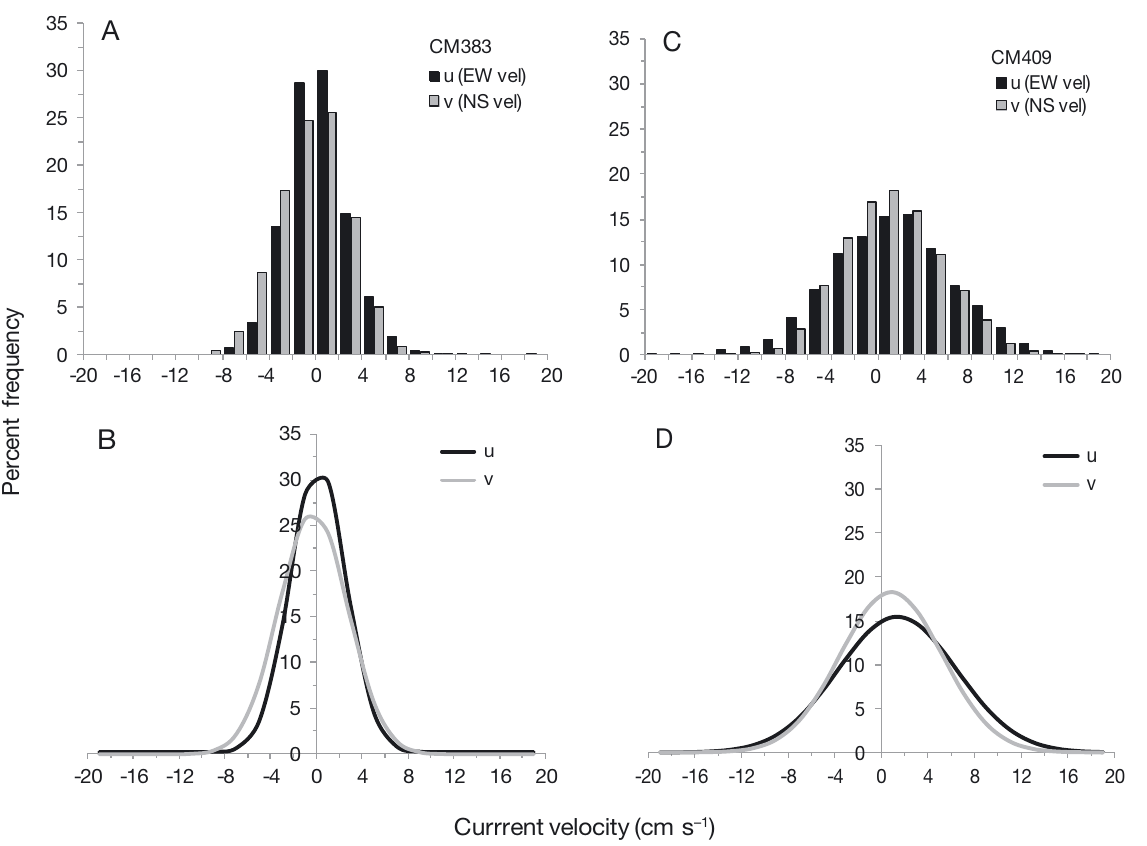
Fig. 3. Data from upward facing acoustic Doppler current profiler (ADCP) CM383 and CM409 moorings in Bliss Harbour in 2009 (Fig. 1, Table 2) summarized from Chang et al. (2014a). (A,B) Frequency distribution for average (near-surface, mid- and near-bottom depths) directional velocity components for ADCP mooring CM383 and fitted normal Gaussian distribution func- tions for east−west (u): y = 1.18 + 31.47 × exp{−0.5 × [ (x + 0.15) / 2.45] 2 } (r 2 = 0.997) and north−south (v): y = −0.03 + 26.56 × exp{−0.5 × [ (x − 0.28) / 3.02) 2 ]} (r 2 = 0.997) velocities. (C,D) Frequency distribution for depth-average velocity components for ADCP mooring CM409 and normal Gaussian distribution functions for u : y = 0.06 + 15.43 × exp{−0.5 × [ (x + 1.36) / 5.11) 2 ]} (r 2 = 0.995) and v: y = −0.04 + 18.33 × exp{−0.5 × [ (x + 0.83) / 4.39] 2 } (r 2 = 0.997) changes, current velocities from the surface to 10 m (side-wall depth) were reduced by half and currents +4.6 and +7.6 m above bottom were increased by a ing the September−November period. factor of 2. The modified current statistics with per- cent of time currents exceed substrate-based thresh- olds for resuspension show the contrasting flow con- ditions for the 2 current meter mooring periods (Table 2).